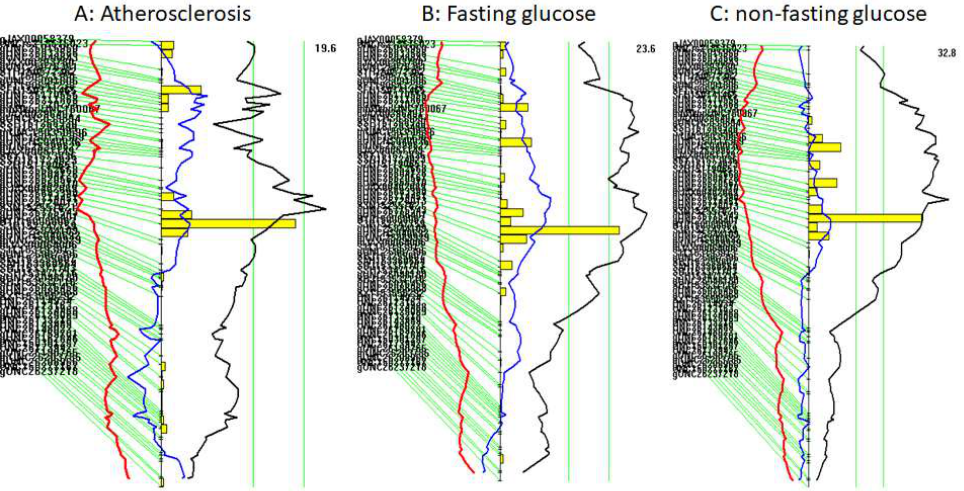
Figure 4. Interval mapping plots for carotid atherosclerosis ( A ), fasting plasma glucose ( B ), and non-fasting glucose ( C ) on chromosome 15. Plots were created using the interval mapping function of Map Manager QTX. The curved black line denotes LOD score calculated at a 1-Mb interval along the chromosome. The red and blue lines denote additive and dominant regression coefficients, respectively. The yellow histograms denote confidence intervals estimated through the bootstrap test. Two vertical green lines denote genome-wide significance thresholds at p = 0.63 and p = 0.05, respectively. Genetic markers used are shown on the left of the figure.